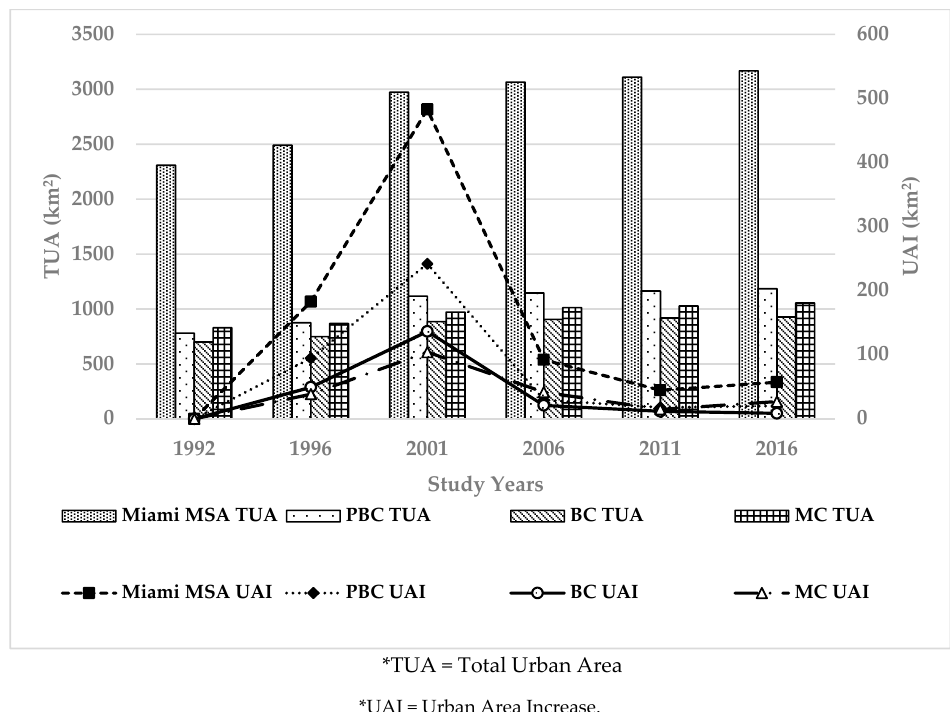
Figure 3. Urban Area Expansion (in km 2 ) in the Study Area over Different Time Periods.